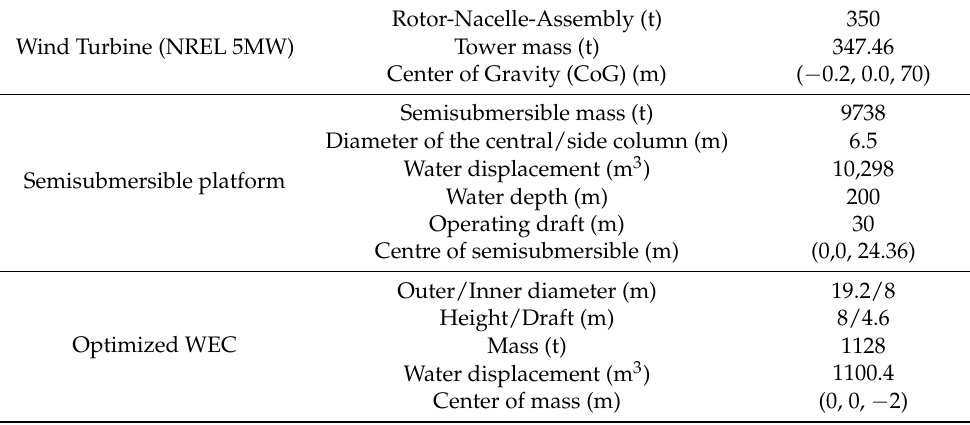
Table 1. The main parameters of the combined